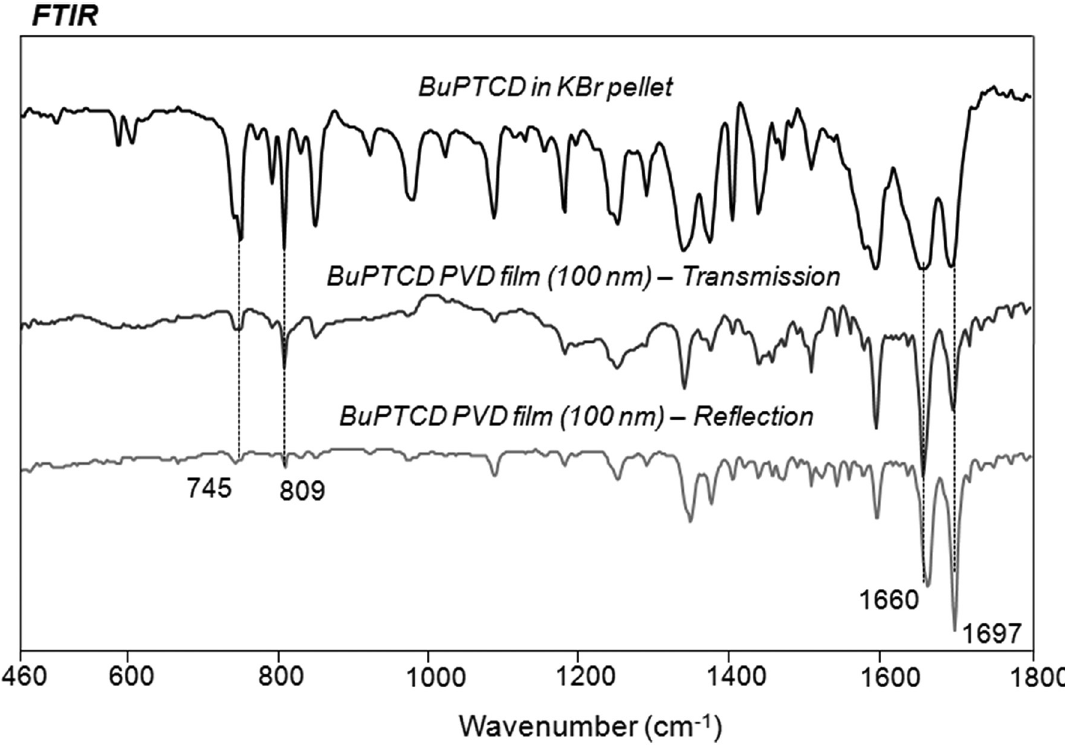
Figure 5. FTIR spectra recorded from BuPTCD powder dispersed in KBr pellet and 100 nm PVD film deposited simultaneously onto Ge (transmission mode) and Ag mirror (reflection